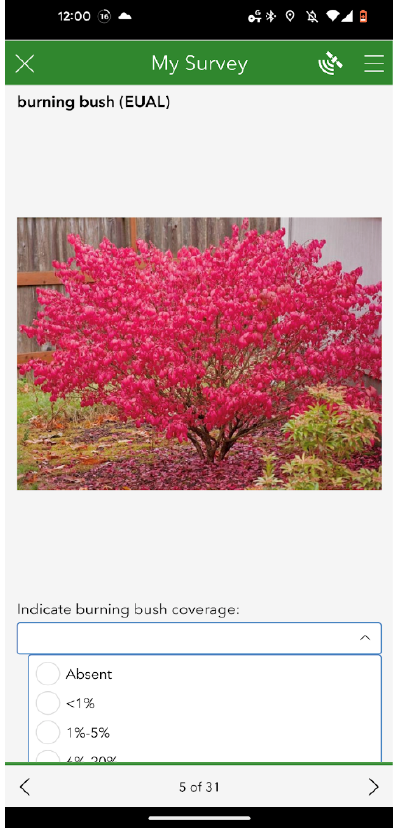
Figure 3. Survey123 entry for burning bush (EUAL). The page shows the name and image of the species and a dropdown option for species coverage at a specific point. The image was captured from a mobile phone Survey123 application.